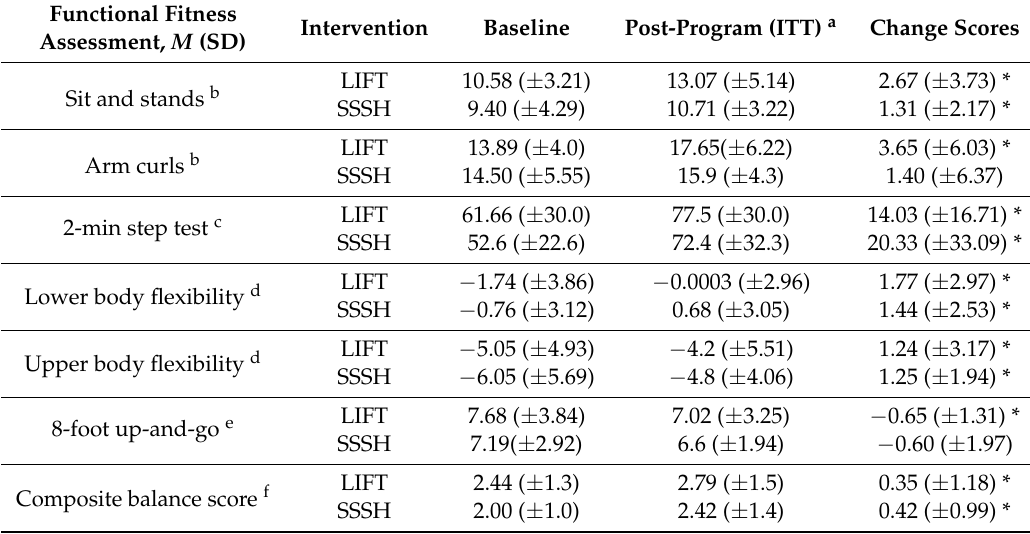
Table 3. Pre- and post-program functional fitness change scores and composite balance change scores, by